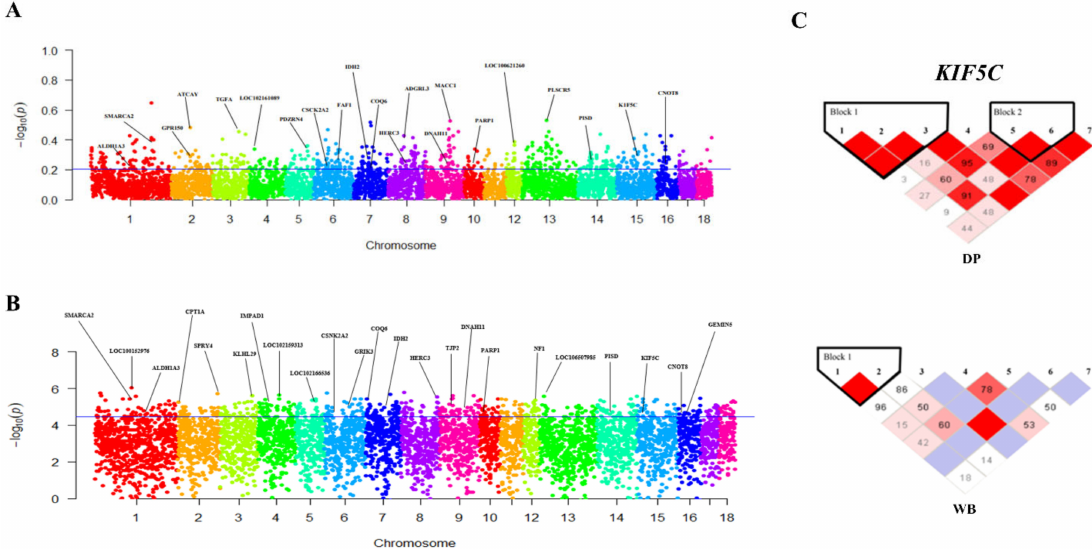
Figure 3. Genome-wide selection scan for SNPs in European WB and DP by using pairwise fixation index ( F ST ) and Tajima’s D. ( A ) Manhattan map of F ST between groups; ( B ) Manhattan map of Tajima’s D between groups; ( C ) Result of genetic linkage of KIF5C by linkage